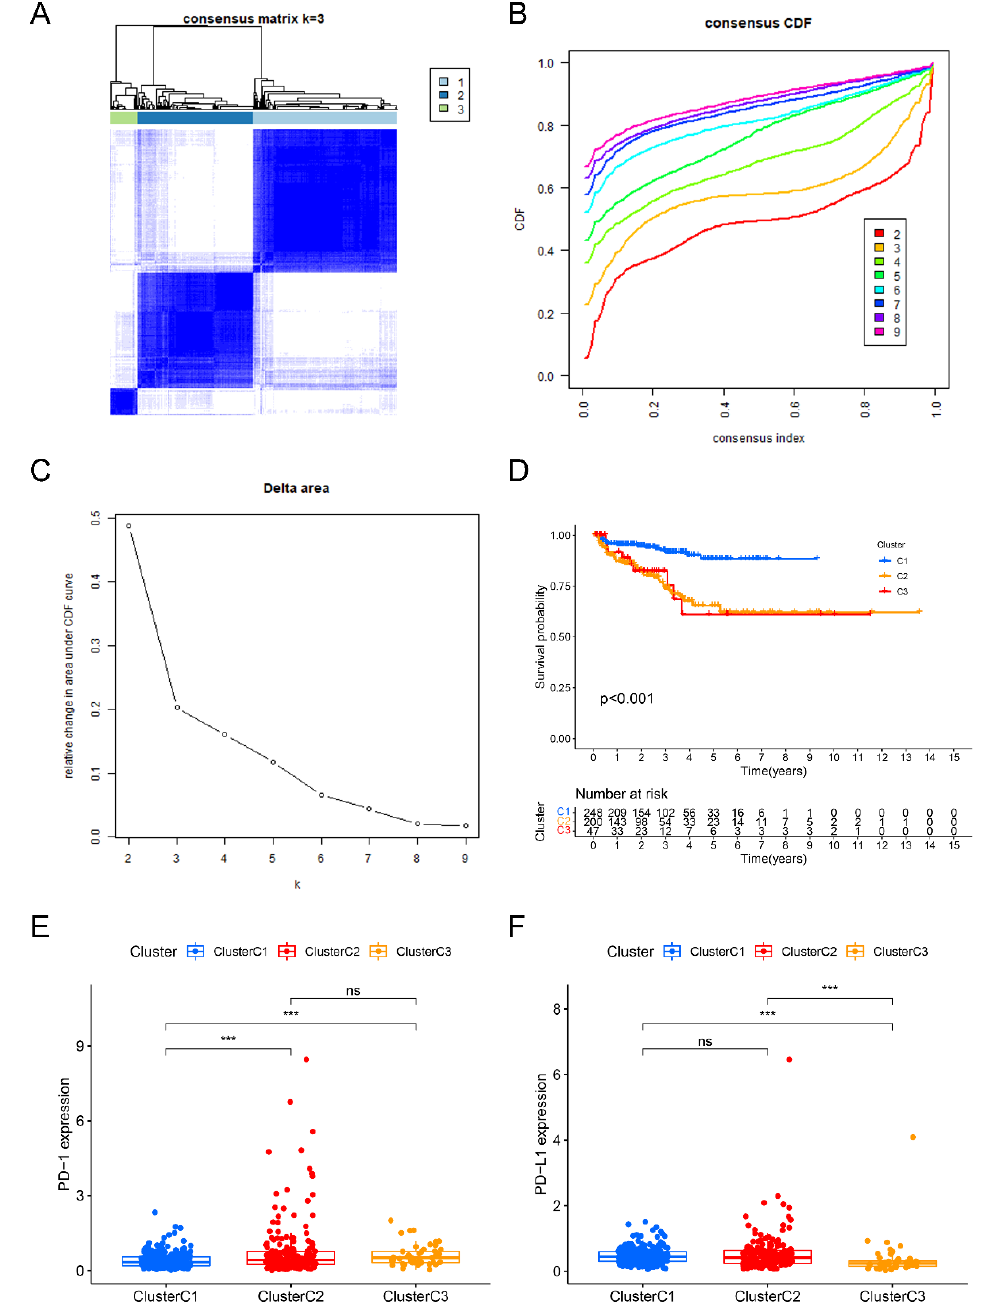
Figure 2. Consensus matrix heat map depicting consensus values on a white-to-blue color scale of each cluster ( A ). CDF plot displaying consensus distributions for each cluster (k) for PCa patients ( B ). Delta area plot reflecting the relative changes in the area under the CDF curve ( C ). The difference of biochemical recurrence free survival ( D ), the relative expression levels of PD-1 ( E ) and PD-L1 ( F ) among three clusters. ***: p < 0.001; ns: not significant.